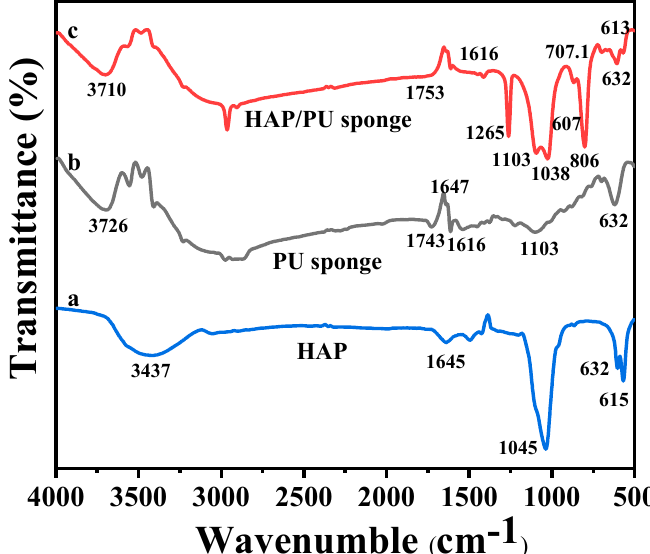
Figure 3. FTIR spectra of ( a ) nano-HAp, ( b ) PU sponge, and ( c ) nano-HAp/PU sponge .